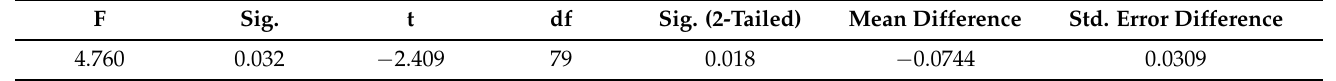
Table 7. Independent samples t -test result for both